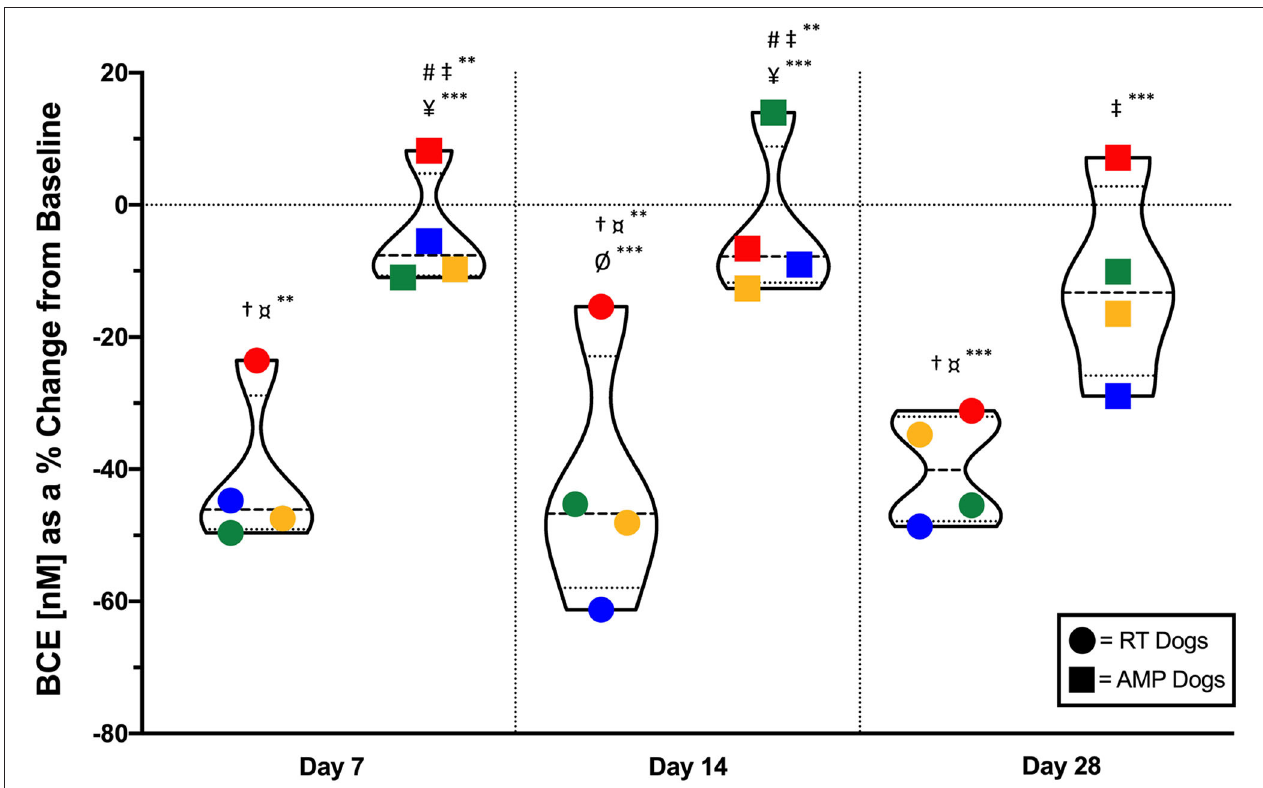
FIGURE 3 | Violin plot of serum N-telopeptide (NTx) concentration, or bone collagen equivalent (BCE), as a percent change from baseline in dogs receiving either zoledronate and RT or amputation for appendicular primary bone tumors. Dogs receiving zoledronate and RT had a 30% or greater percentage decrease in BCE by day 28 of the study; no dogs in the amputation arm had a decrease of 30% ( p = 0.029). Dogs are grouped by treatment modality (zoledronate and RT, circles; amputation, squares). Individual dogs can be tracked by color in each group. Means and standard deviation are noted by thicker hash mark and thinner hash mark within the violins, respectively. # Significantly different from RT Dogs on Day 7. † Significantly different from AMP Dogs on Day 7. ‡ Significantly different from RT Dogs on Day 14. ¤ Significantly different from AMP Dogs on Day 14. U Significantly different from RT Dogs on Day 28. Ø Significantly different from AMP Dogs on Day 28. **Significant difference ( p < 0.01). ***Significant difference ( p <